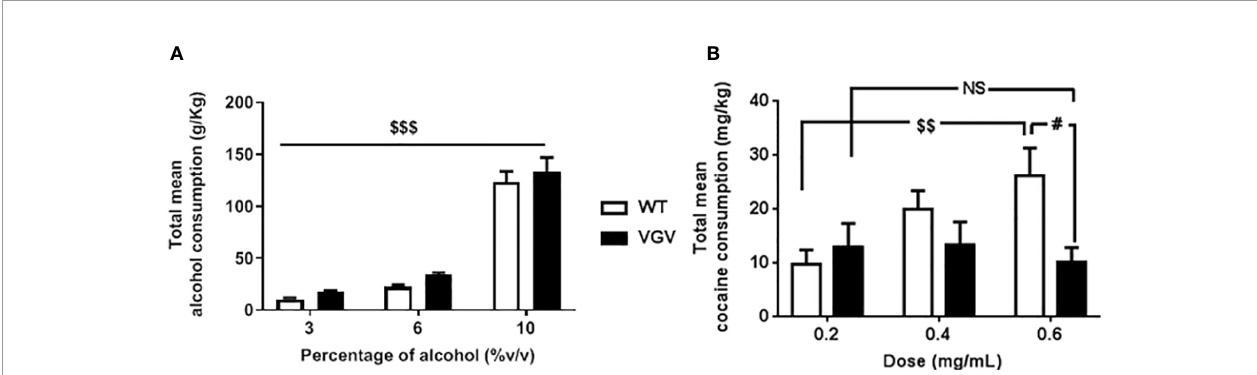
FIGURE 1 | Evolution of alcohol and cocaine consumption in VGV mice. Total free-choice consumption of alcohol (A) or cocaine (B) in VGV and WT mice in a 3- week-progressive drug treatment. (A) ANOVA analysis with repeated measures showed a main effect of alcohol concentration [F(2,60) = 163.4, p < 0.001] but no effect of genotype [F(1,30) = 1.97, p = 0.17] and no interaction [F(2,60) = 0.06, p = 0.94]. (B) There was a signi fi cant interaction genotype × cocaine-dose effect [F (2,36) = 3.46, p <0.05], but no effect of genotype [F(1,18) = 2.87, p = 0.11] or of cocaine concentration [F(2,36) = 1.95, p = 0.16]. The mean consumption of cocaine did not increase in VGV mice with the increasing dose contrary to WT mice (p < 0.01), and for the highest dose (0.6 mg/ml) VGV mice exhibited almost ~60% less consumption compared to WT mice (WT vs VGV, p < 0.05). Data are expressed as mean ± S.E.M. VGV vs WT mice, (alcohol-treated WT and alcohol- treated VGV mice, n = 16; cocaine-treated WT mice, n = 8; cocaine-treated VGV mice, n = 12, # p < 0.05, effect of drug concentration, $$ p <0.01, $$$ p <0.001). NS, non signi fi